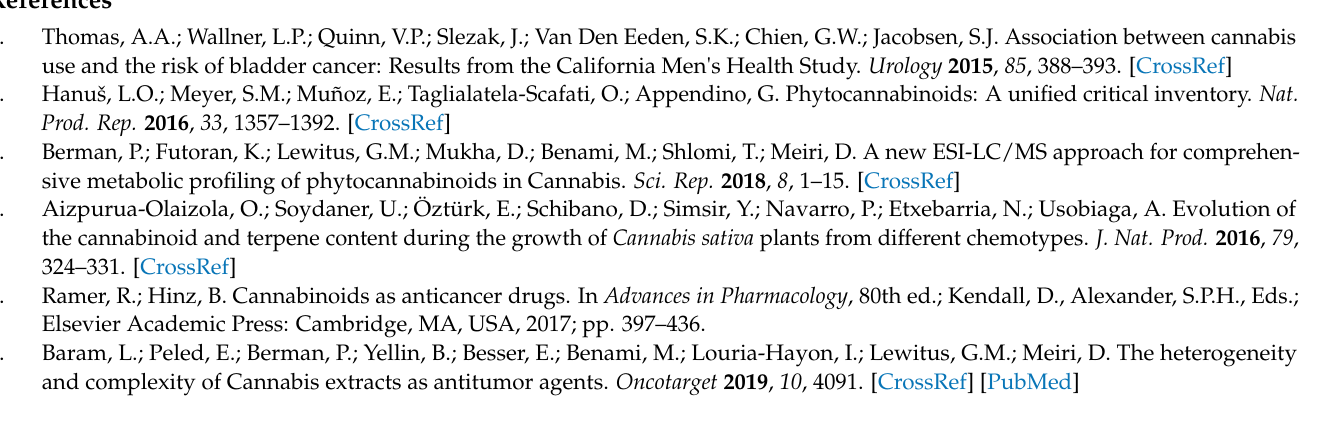
Table S1: Phytocannabinoid composition of the crude extract and fractions of Israel Gene Bank strain based on HPLC analysis, Table S2: The experimental (observed) and the calculated (expected) values of the synergistic interactions between CBC and THC on cell viability of T24 cells